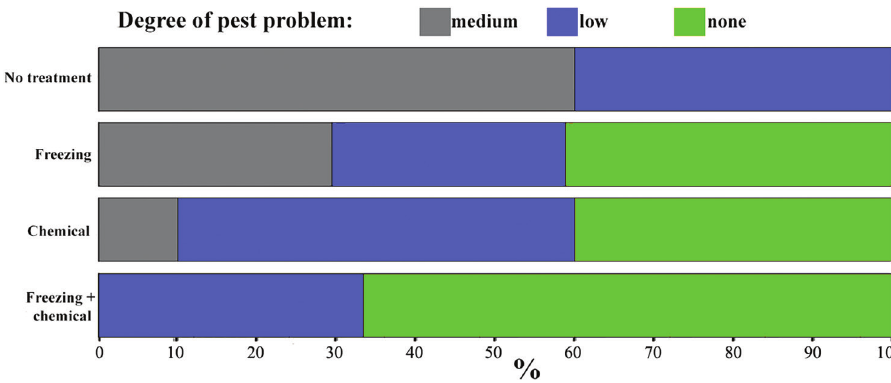
Figure 2. Stacked bar chart showing the relationship between the degree of pest problem and the treat- ments to prevent it in the Italian private